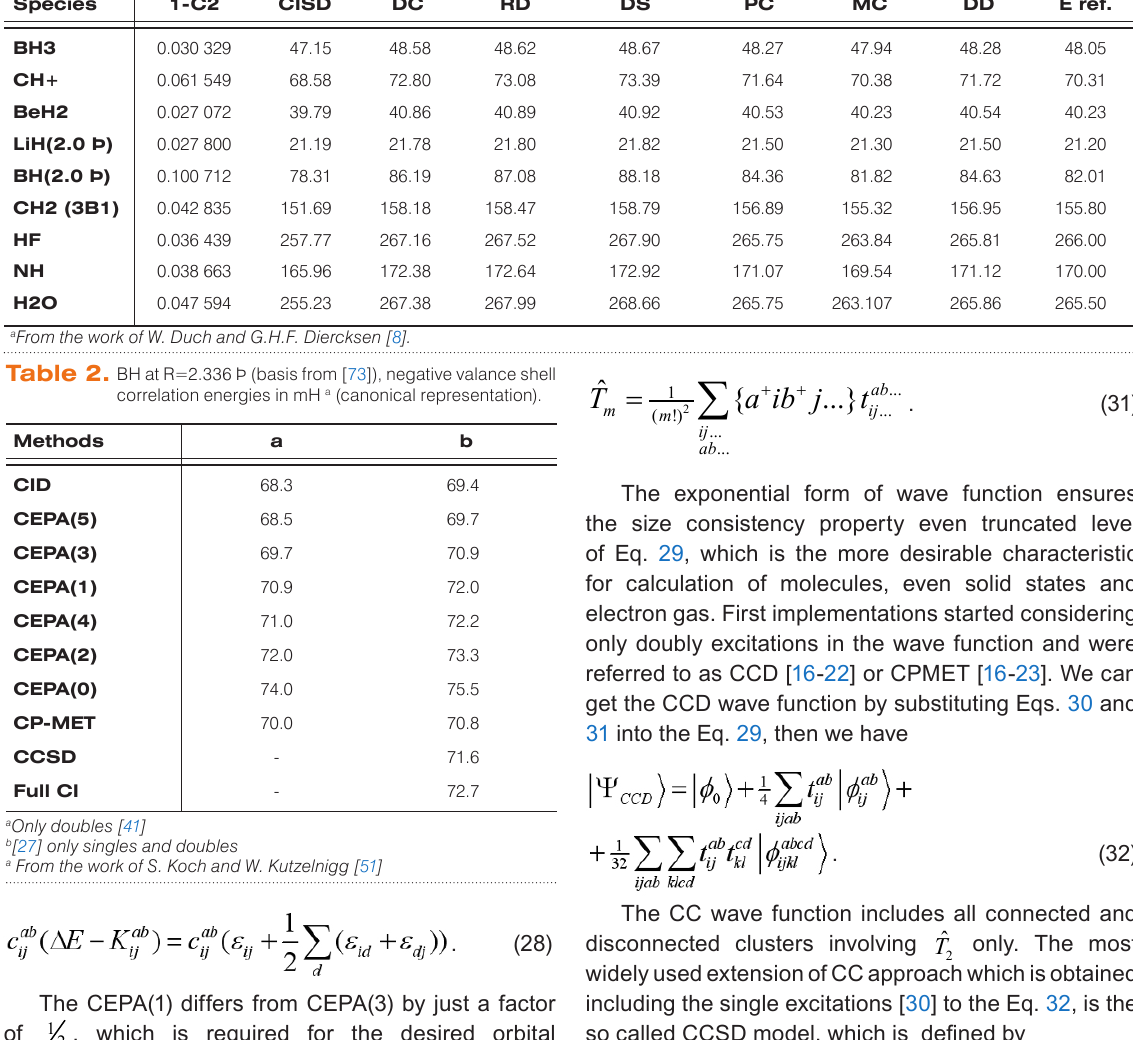
Table 1. The comparison of size consistency corrections of some small molecules a . Correlation energy is given in mH. Species